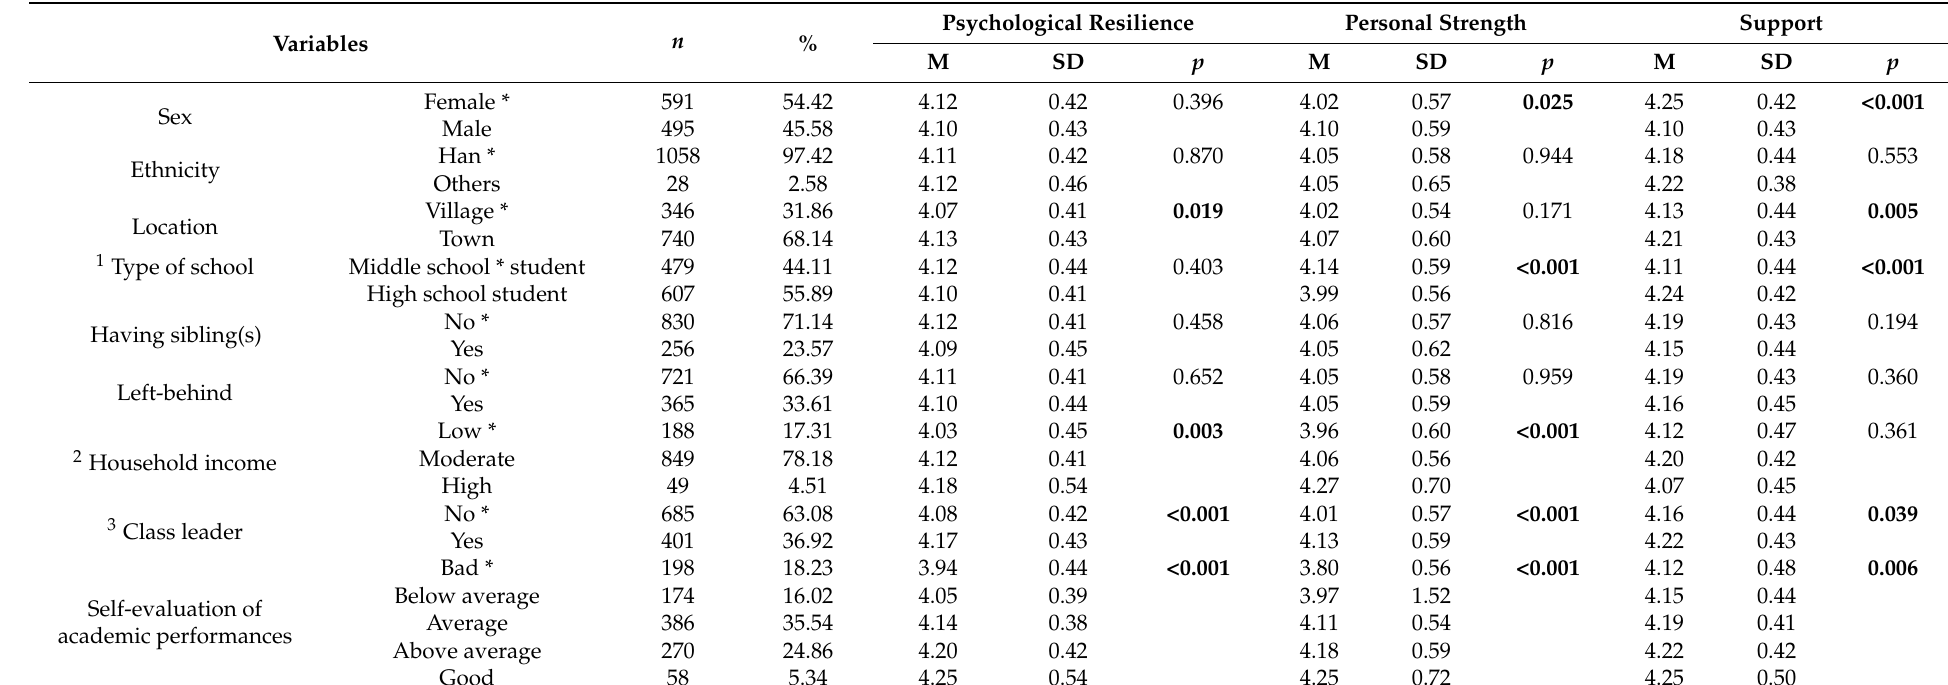
Table 1. Psychological resilience among the study